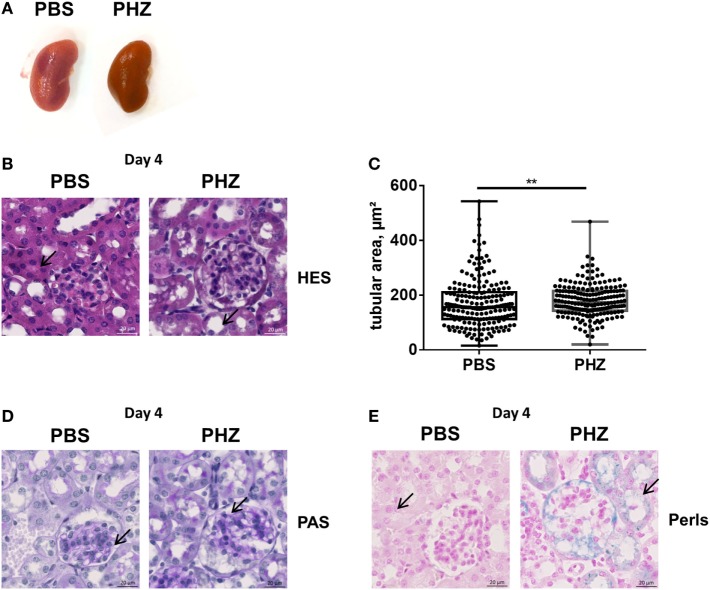
Renal histology of phenylhydrazine (PHZ)-treated mice. (A) Representative images of kidneys from PBS- and PHZ-treated mice. (B) Fixed and paraffin-embedded kidneys from mouse sacrificed at day 4 were cut at 3 µm and stained with hematoxylin–eosin (×15). (C) Quantitative analysis of proximal tubular size; each point represents the size of one tubule (n = 200). Mean ± SD, ** p < 0,005, and Mann–Whitney test. (D,E) Fixed and paraffin-embedded kidneys (×20) from mice sacrificed at day 4 were cut at 3 µm and stained with PAS (D), Perl’s Prussian Blue (E). Black arrows point to tubules lumen (B), to glomerular mesangium (D), or to iron deposition (E) in PBS- and PHZ-treated mice.